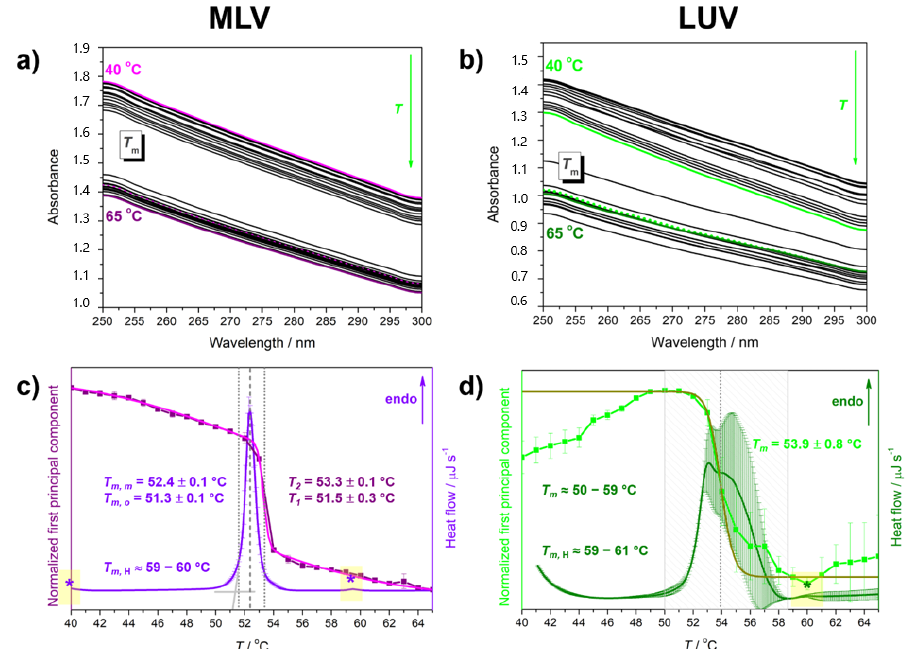
Figure 2. Temperature-dependent UV/Vis spectra of DPPS in the following forms: ( a ) MLV (40 °C: magenta solid curve, 65 °C: purple solid curve, spectral profile of the principal component: magenta dotted curve) and ( b ) LUV (40 °C: green dotted curve, 65 °C: olive solid curve, spectral profile of the principal component: green dotted curve). Concentration profiles of the (first) principal components that project temperature-dependent UV/Vis spectra and DSC curves of DPPS: ( c ) MLV (DSC: violet curve; UV/Vis: purple curve for spectral projection and magenta curve for double sigmoidal fit) and ( d ) LUV (DSC: olive curve; UV/Vis green curve for spectral projection and dark yellow curve for single sigmoidal fit). Phase transition temperatures determined from DSC (intersected lines for o and dashed lines for m ) and UV/Vis experiments (dotted lines) are highlighted with corresponding colors on graphs. * and yellow rectangles refer to the L c → L β (in MLV only) and T m, H of DPPS (in both MLV and LUV).